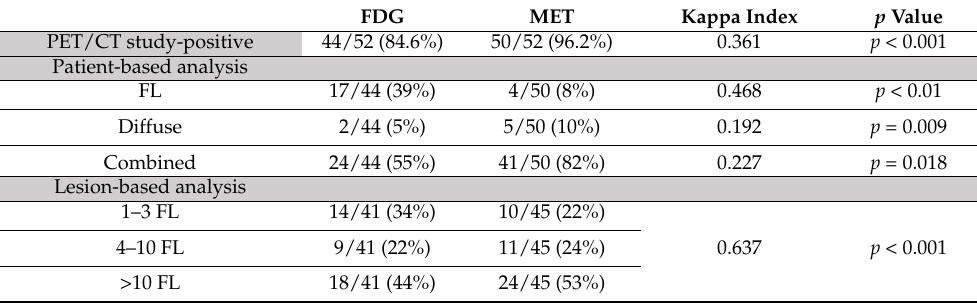
Figure 4. Patient with SMM with heterogeneous BM uptake in the axial (blue arrow-( a )) and appendicular skeleton (arrow head-( a )) in MET PET/CT. FDG PET/CT was negative for pathological focal tracer accumulation related to high metabolic lesions. BM uptake in the axial (blue arrow-( b )) and appendicular skeleton (arrow head-( b )) was homogeneous and lower than the mediastinal blood pool (Deauville 2). With these findings, this patient would be classified as negative or low-risk based on the FDG PET/CT and so not a candidate for the start of treatment. Table 2. Uptake patterns of FDG and MET